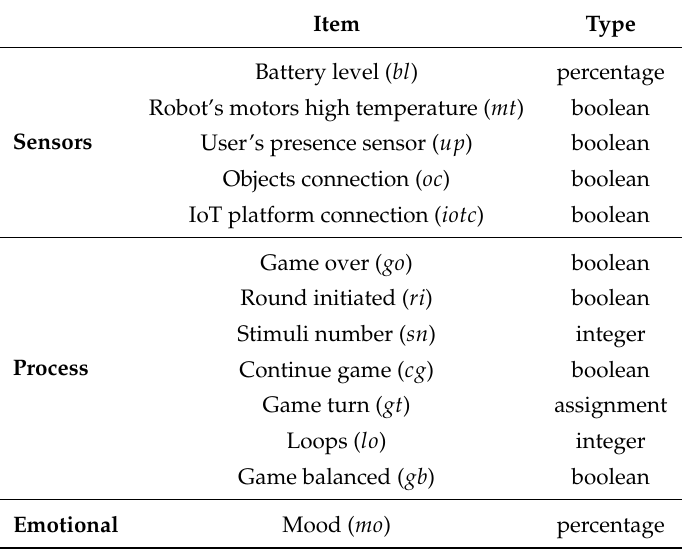
Table 1. Items considered in the knowledge